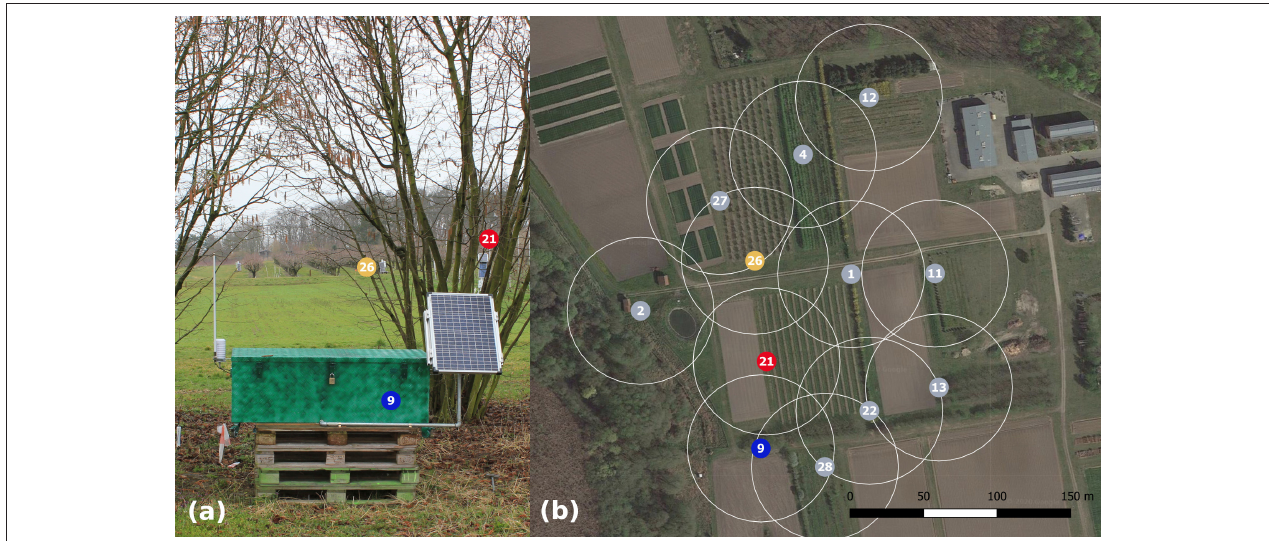
FIGURE 11 | Installation at the Marquardt test site of the Leibniz Institute for Agricultural Engineering and Bioeconomy with CRNPs compared in Figure 12 . (a) Preliminary setup of sensor 9 in its camouflage box with external solar panel and GSM antenna. (b) Bird’s eye view of the site. The neutron detectors are located with overlapping footprints (50m radius, white circles). Background image, map data: Google imagery.